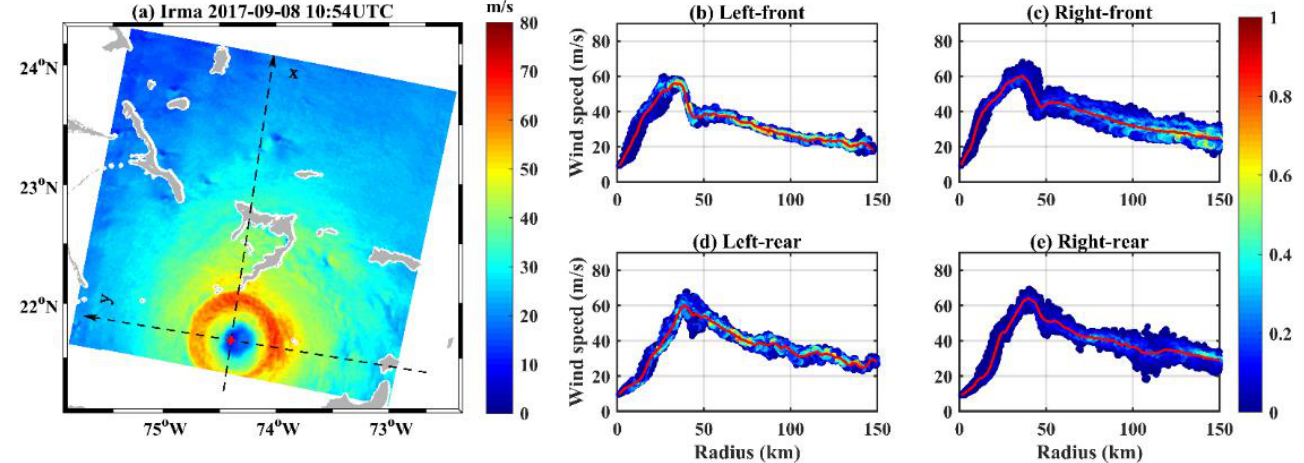
Figure 12. The same as Figure 11 but for the RS-2 SAR image at 10:54 UTC on 8 September